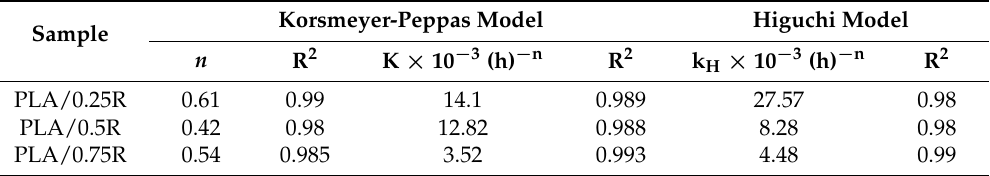
Table 9. Migration kinetic parameters for the active ingredients of the powdered rosemary ethanol extract from PLA-based materials into 50% ethanol solution as a food simulant